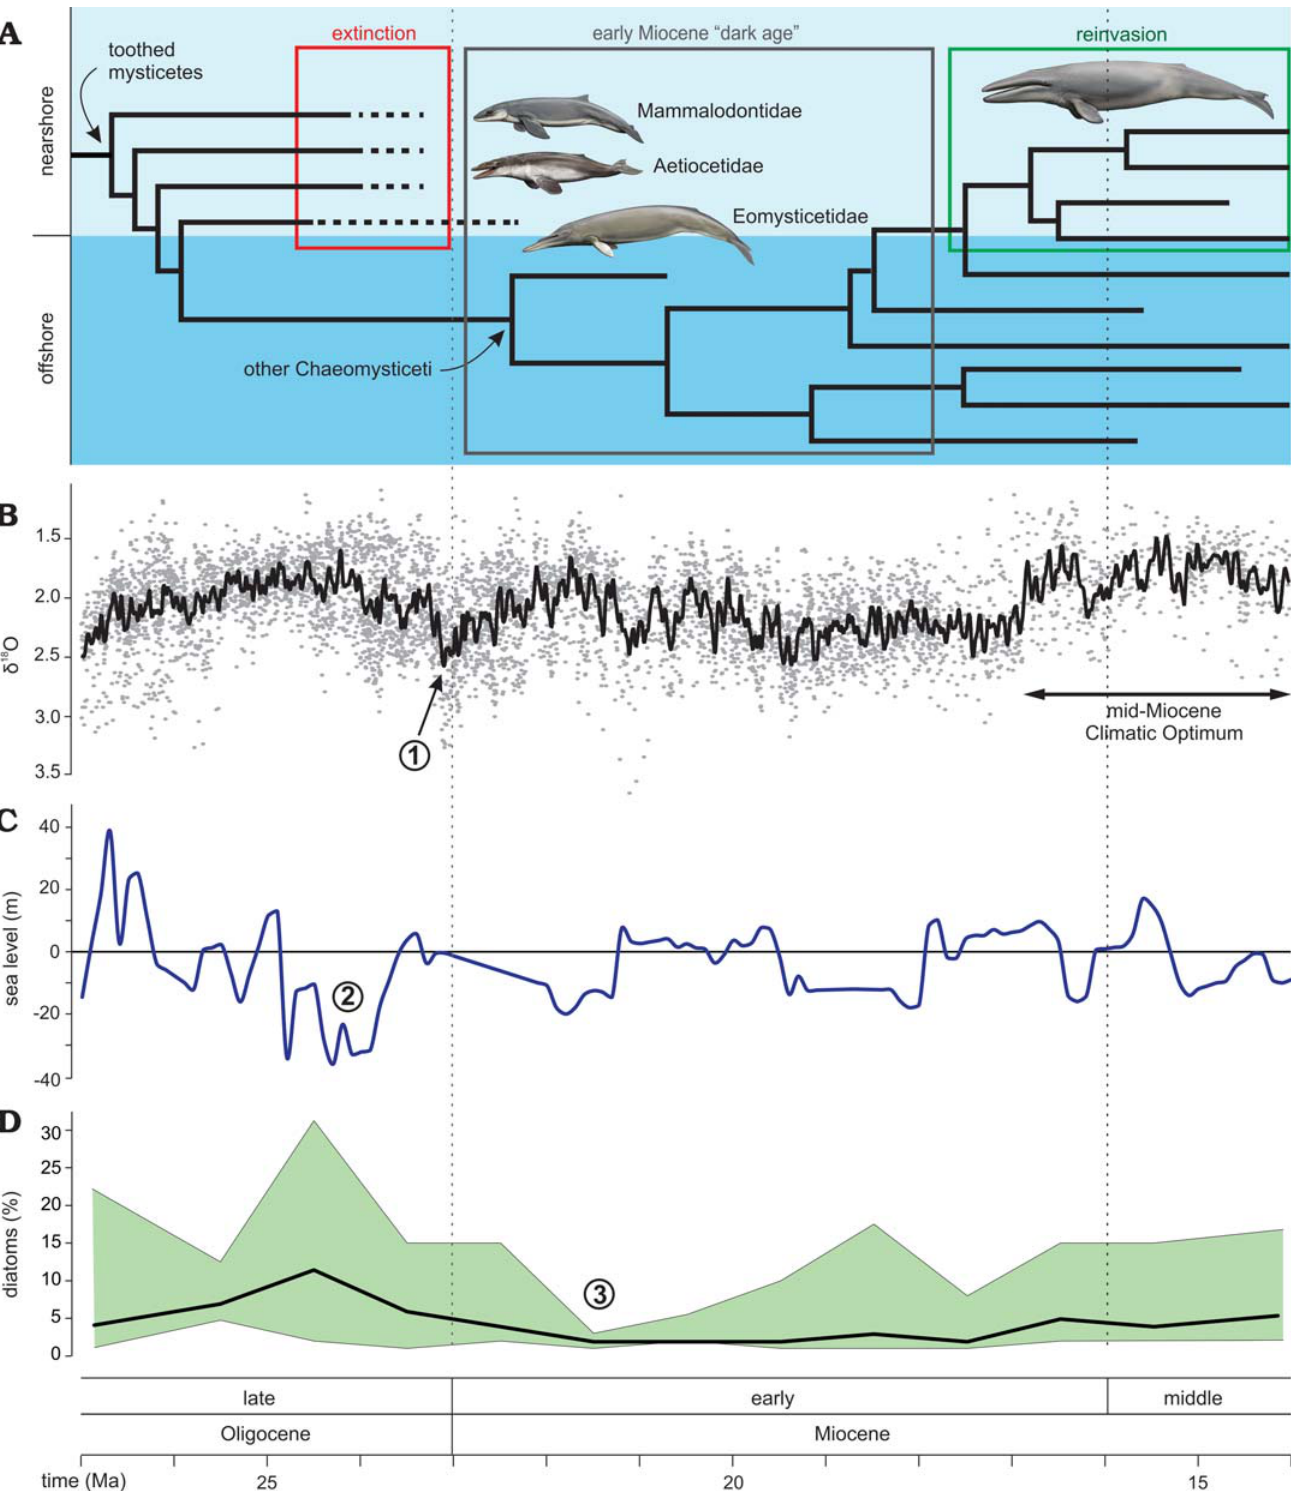
Fig. 3. Patterns and potential drivers of the early Miocene “dark age”. A . Extinction of toothed mysticetes and eomysticetids at the beginning of the early Miocene “dark age”, and subsequent reinvasion of coastal habitats by larger, toothless filter feeding mysticetes during the middle Miocene. The occurrence of eomysticetids in the earliest Miocene is based on a single, fragmentary specimen from New Zealand (Boessenecker and Fordyce 2017b). B . Global oxygen isotope curve, showing the timing of the mid-Miocene Climatic Optimum (Zachos et al. 2008). C . Global sea-level change (Miller et al. 2005). D . Global diatom abundance as derived from Deep-Sea Drilling Programme/Ocean Drilling Programme smear slides (Renaudie 2016). Highlighted events potentially relevant to the “dark age”: 1, a 0.5 shift in δ 1 8 O; 2, a 40 m sea-level fall; and 3, an early Miocene decrease in global diatom abundance. Reconstructions of mysticetes by Carl